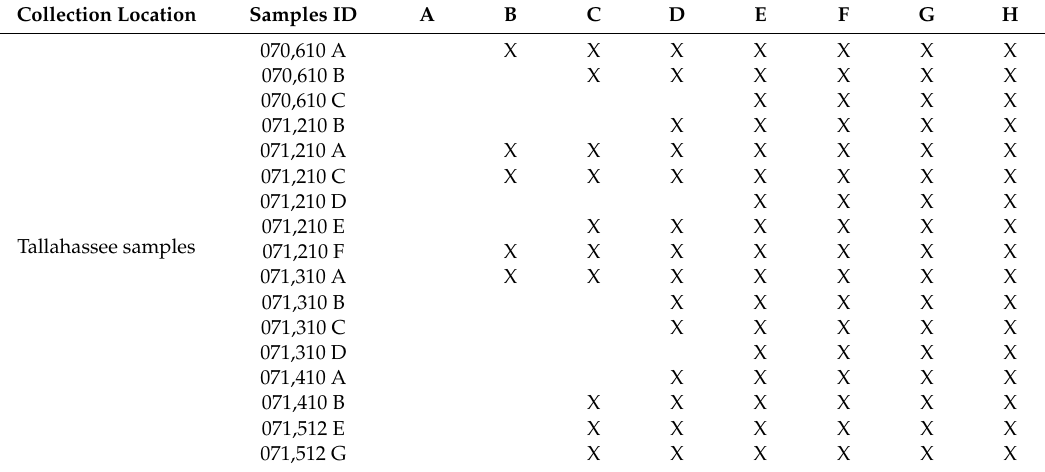
Table 2. Results from Mitomycin C experiments. Columns marked with and “X” indicate turbidity and no visible clearing of the wells. Unmarked columns indicate visible clearing. Columns A through H represent the dilution series 10 0 (A = 18 µ g mitomycin C) through 10 6 (G = 18 pg mitomycin C) and the negative control well (H), respectively. Column A wells were used for direct counts. No clearing was noted in any of the matched control wells utilized as an additional